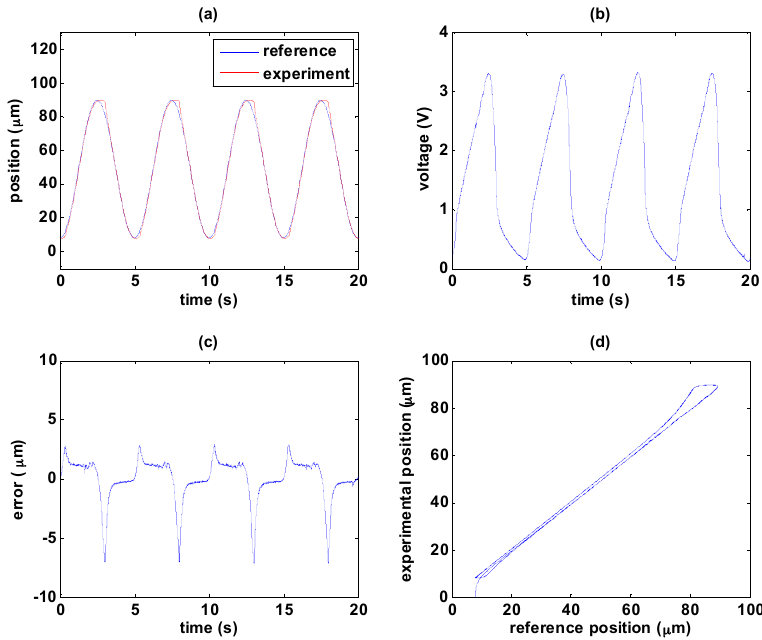
Figure 12. Path tracking of sinusoidal wave with PID controller: ( a ) path tracking responses; ( b ) control signals; ( c ) control errors; ( d ) linear relationship between reference and experimental positions.